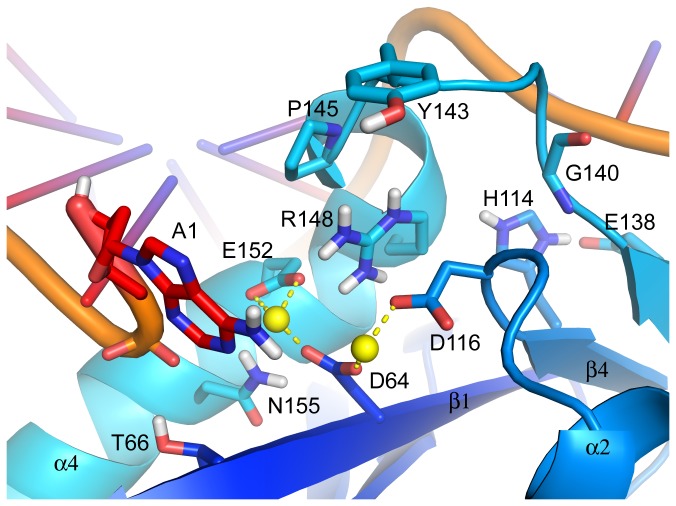
Structural model of Q148R HIV-1 integrase with U5 LTR DNA.The side chain of residue Q148R was modeled interacting with the side chain of E152 and in this conformation the residue may interfere with the binding of elvitegravir. Molecular representations and coloring schemes as described in Figure 2.